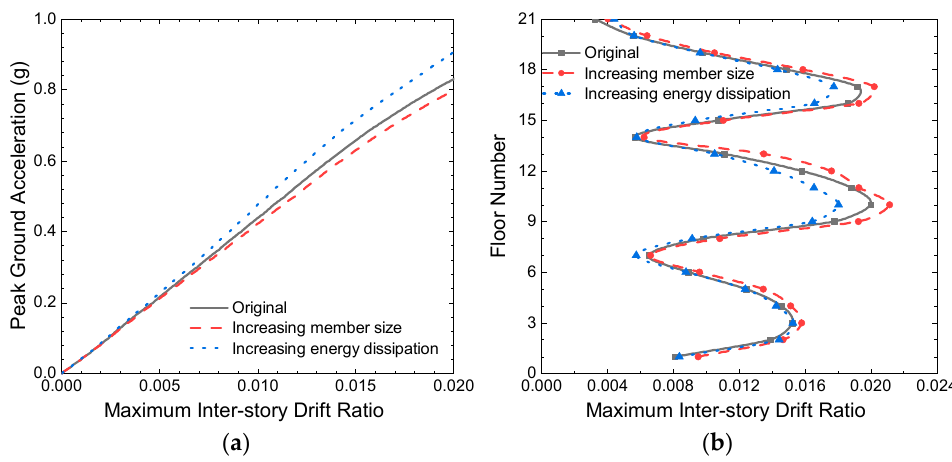
creased compared to the original structure.